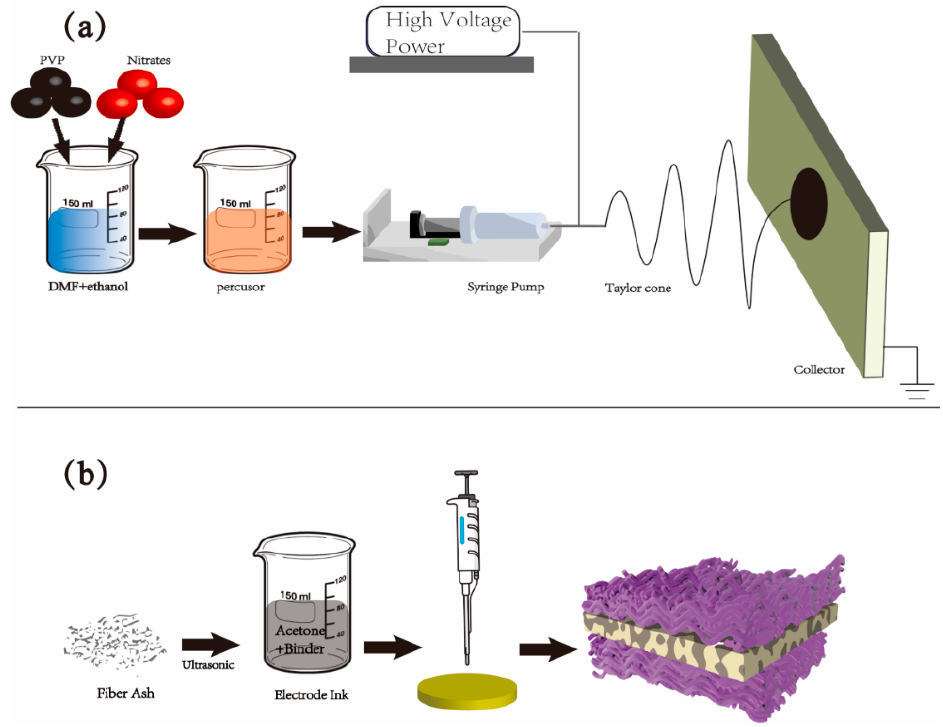
Figure 1. Schematic illustration of the electrospinning process for fiber fabrication ( a ) and electrode preparation for nanofiber-based electrodes ( b ).